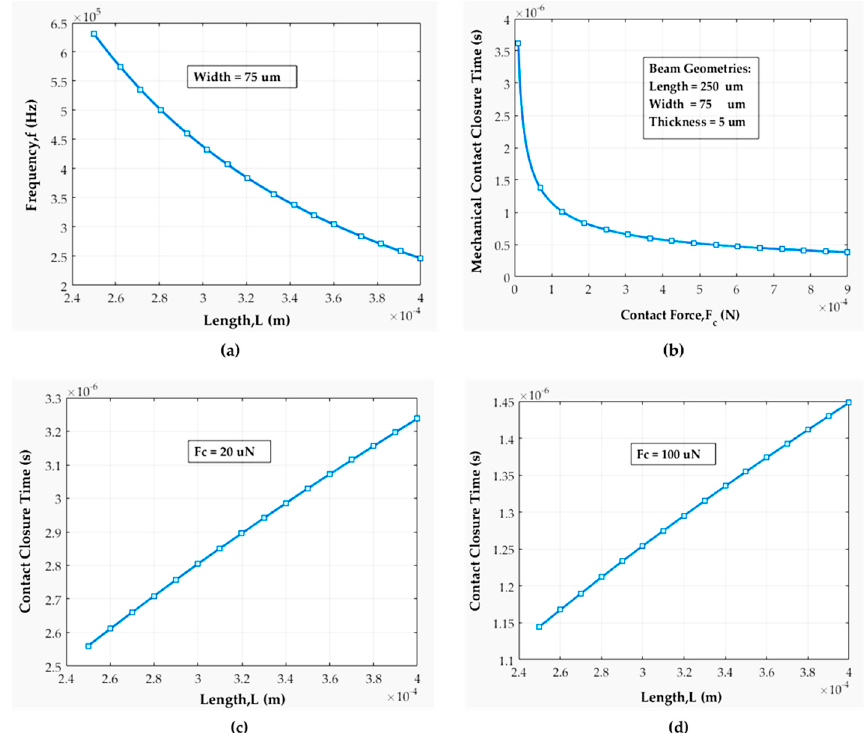
Figure 13. ( a ) Resonance frequency with beam’s geometry; ( b ) mechanical contact closure time with available contact force; ( c ) mechanical contact closure time versus beam length for 20 µ N contact force; ( d ) mechanical contact closure time versus beam length for 100 µ N contact force.